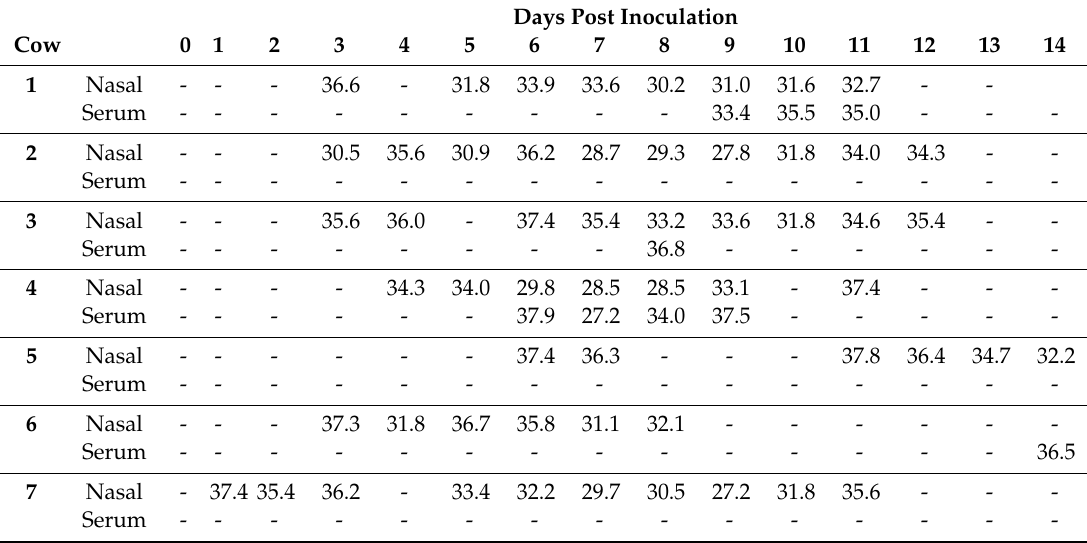
A dash indicates that Bungowannah virus RNA was not detected.